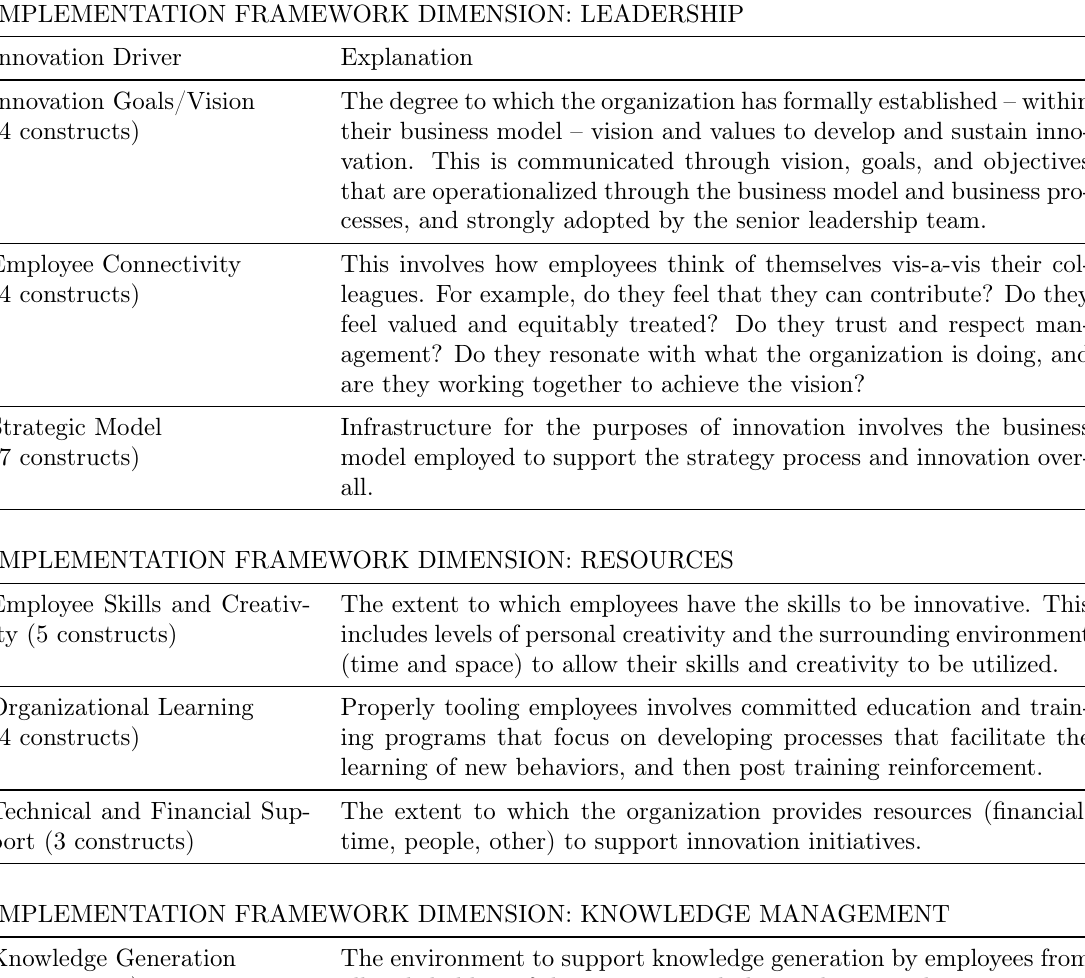
Table 1. Innovation Drivers (adapted from Dobni and Klassen,